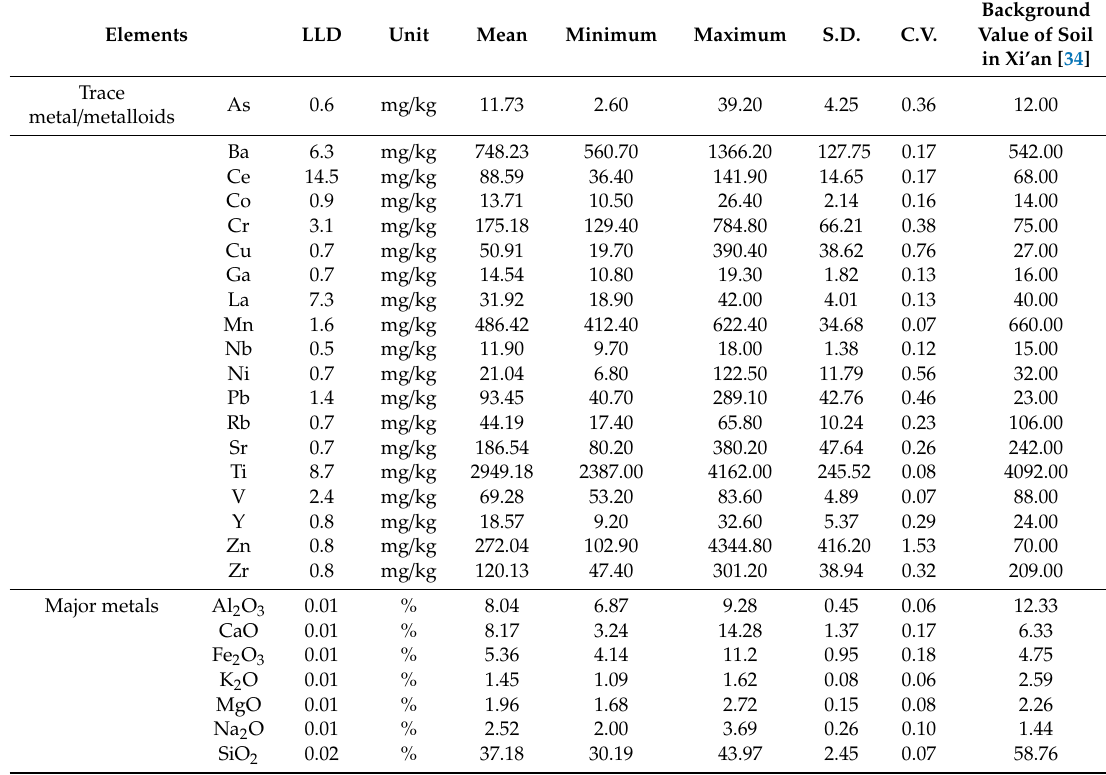
Table 1. Statistical results of chemical elements content in Street dust in